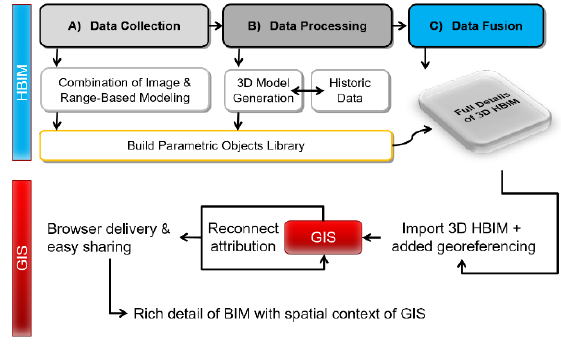
Figure 7. Integrating HBIM and